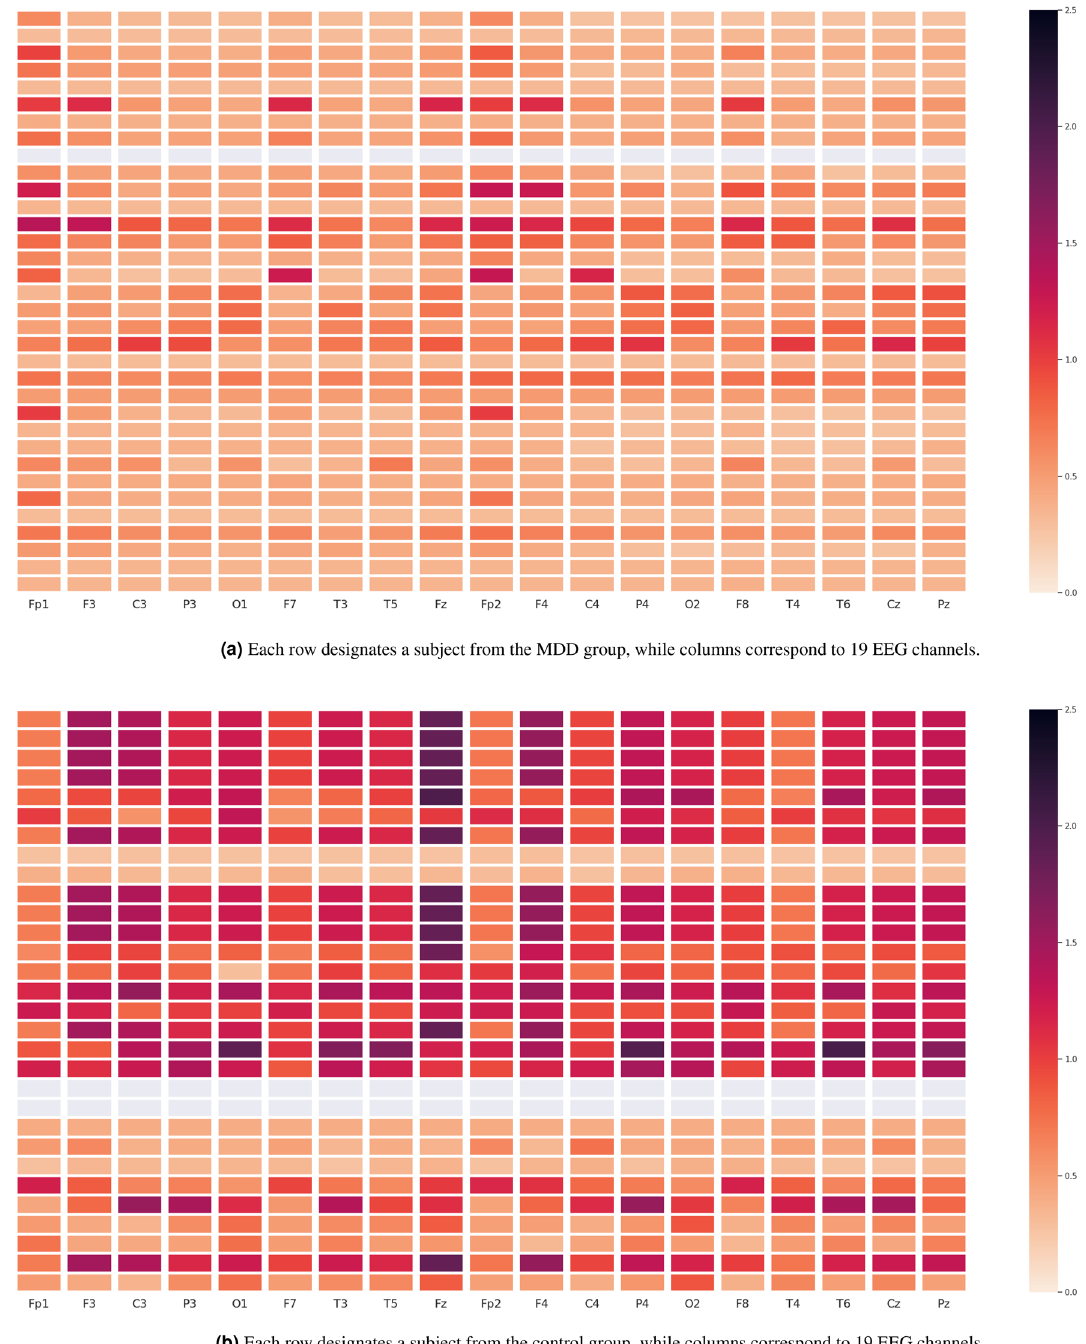
Figure 9. Heat maps of the differential entropy of action potential distributions when performing